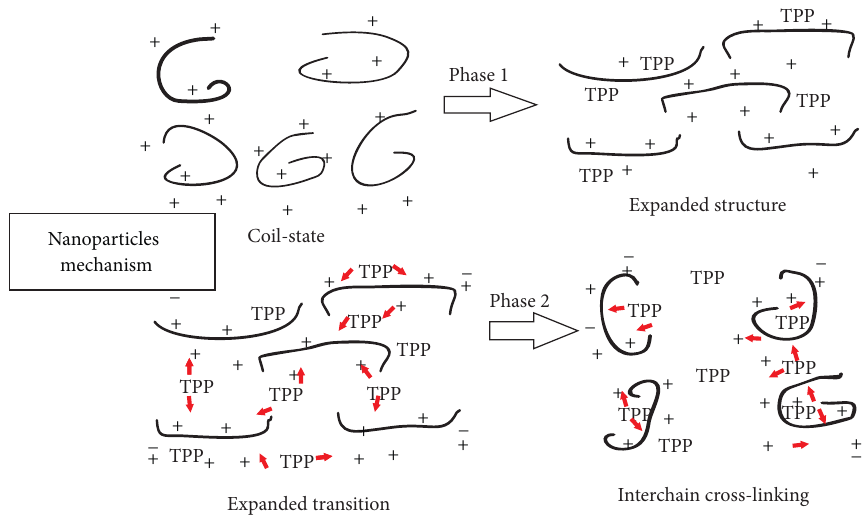
Figure 11: Two-phase mechanism of nanoparticles formation.